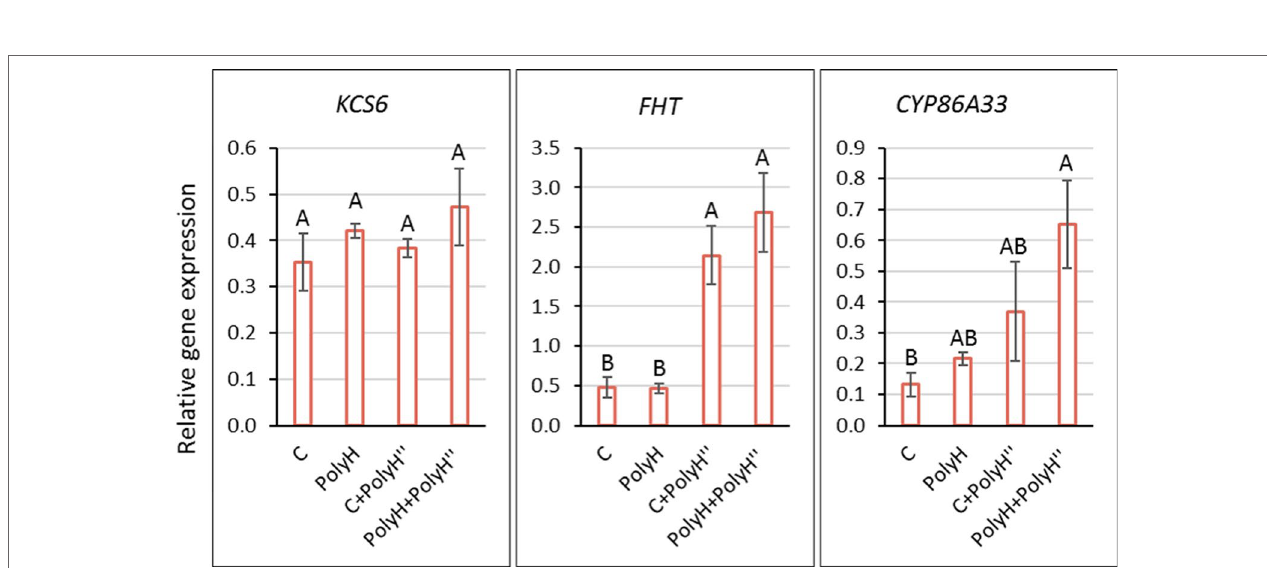
FIgURE 2 | Visual evaluation of Rosanna tubers from experiment 1. Samples labeling is as described in legend of Figure 1 . Visual evaluation of tuber appearance was performed 24 h after harvest (a) and after 1 month of storage (B) . Values are averages of six replicates with SE. Each replicate consisted of 12 tubers. Visual index was determined on a scale of 1 to 5: 5 = good skin quality, 1 = low skin quality, by a panel of four individuals who rate commercial products routinely. Data were analyzed for statistical significance by Student’s t -test; different letters indicate significantly different values ( P < 0.05).